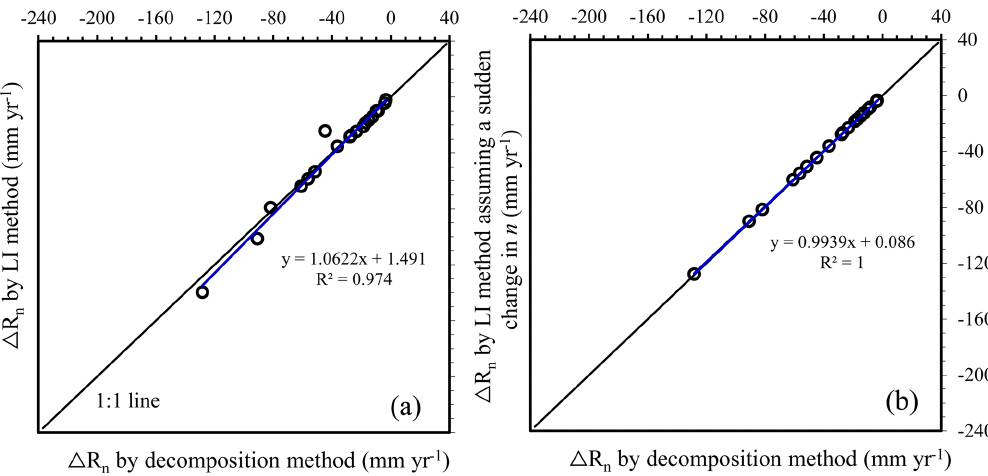
Figure 4. Comparisons between the LI method and the decomposition method. (a) Comparison of the estimated contributions to the runoff changes from the catchment changes ( (cid:49)R n ) . (b) The decomposition method is equivalent to the LI method that assumes a sudden change in catchment properties following climate change. In this case, the integral path of the LI method can be considered as the path ABC in Fig. 3 ( x represents climate factors, and y catchment properties, i.e., n ) and (cid:49)R n = (cid:82) (cid:82) n 2